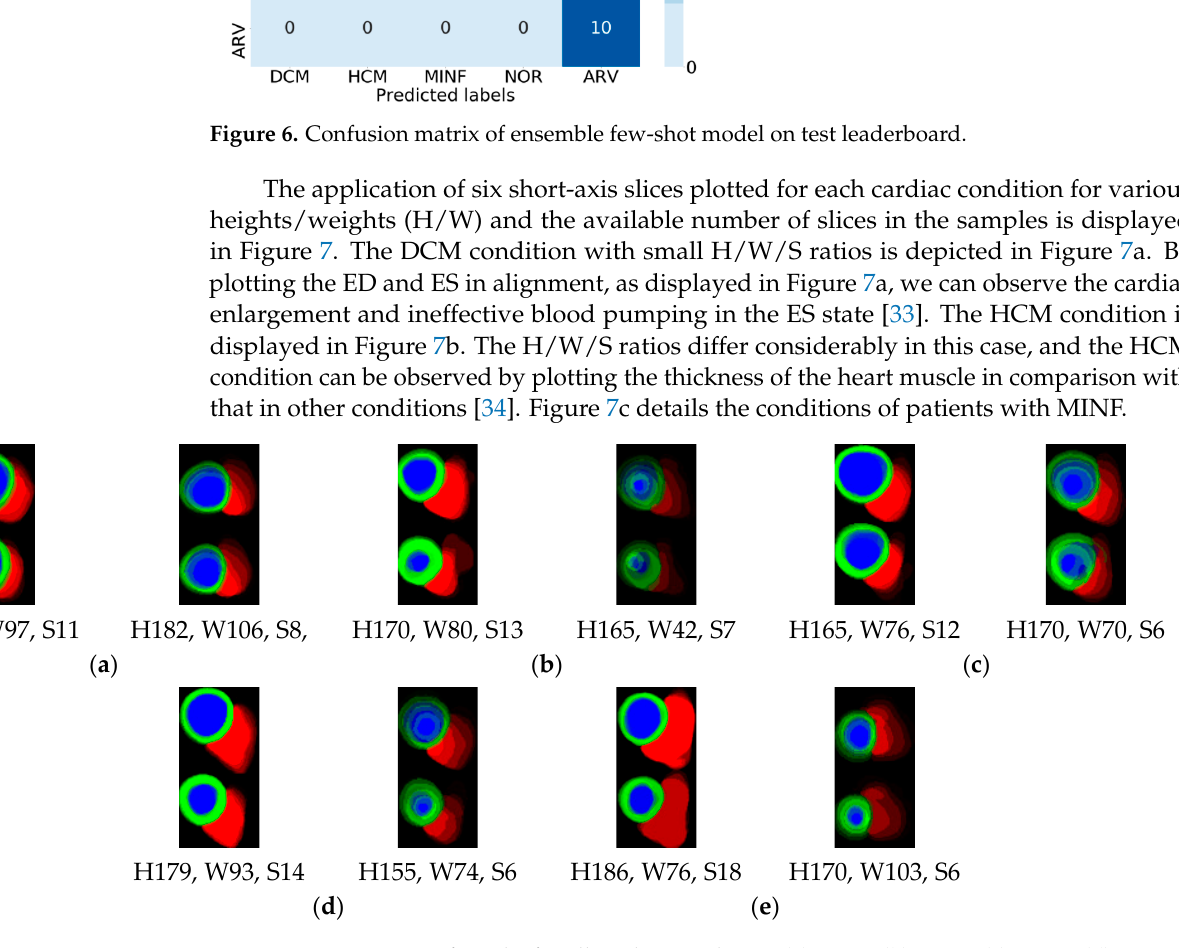
Figure 7. Comparison of results for all cardiac conditions ( a ) DCM, ( b ) HCM, ( c ) MINF, ( d ) normal, and ( e ) ARV, with H: height, W: weight, S: slices.